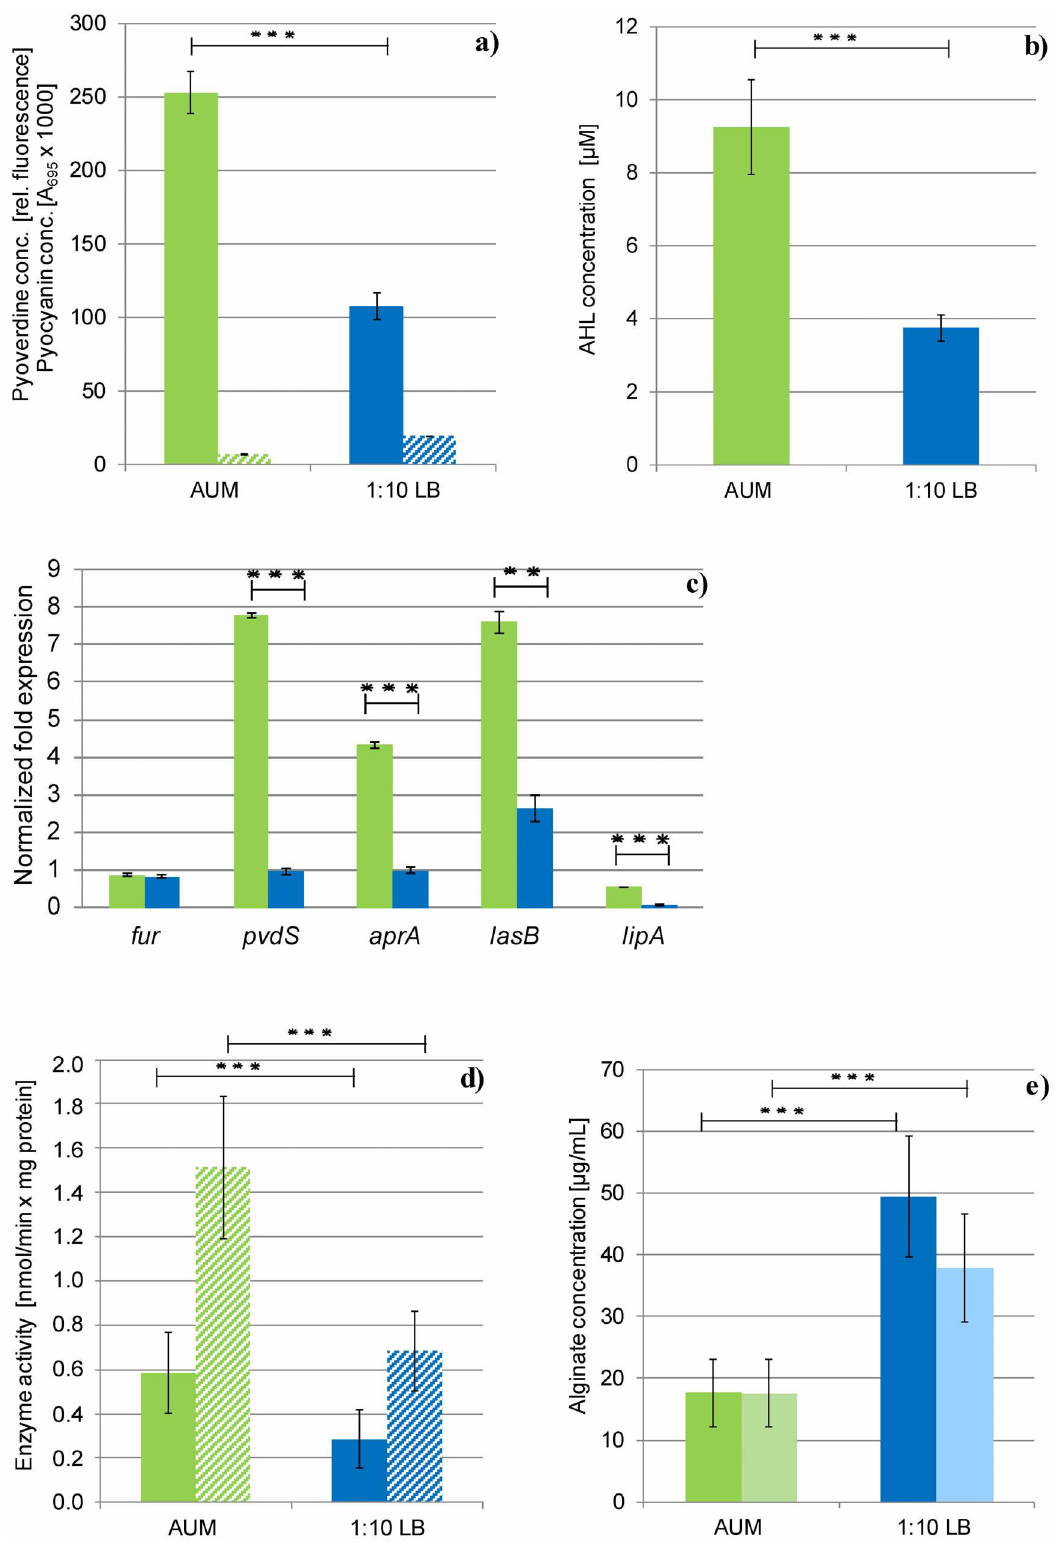
Figure 2. Virulence factor production under urinary tract conditions. a) Determination of pigments. The siderophore pyoverdine (uni) and the redox-active pyocyanin (stripes) were measured in supernatants of anaerobically grown P. aeruginosa PAO1 from AUM (green) and 10-fold diluted LB cultures (blue). The results are expressed as mean value + / 2 standard deviation (SD) of three independent experiments performed in triplicates. *** p =0.04. b) Quorum sensing activity of P. aeruginosa grown anaerobically in biofilms on AUM (green) or 10-fold diluted LB (blue). The results are expressed as mean value + / 2 SD of three independent experiments performed in triplicates. *** p =0.002. c) Expression of the fur , pvdS , aprA , lasB